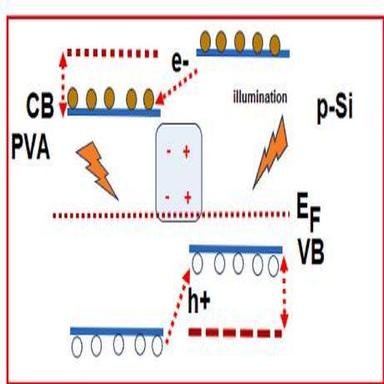
Band Alignment of PVA/p-Si heterojunction.